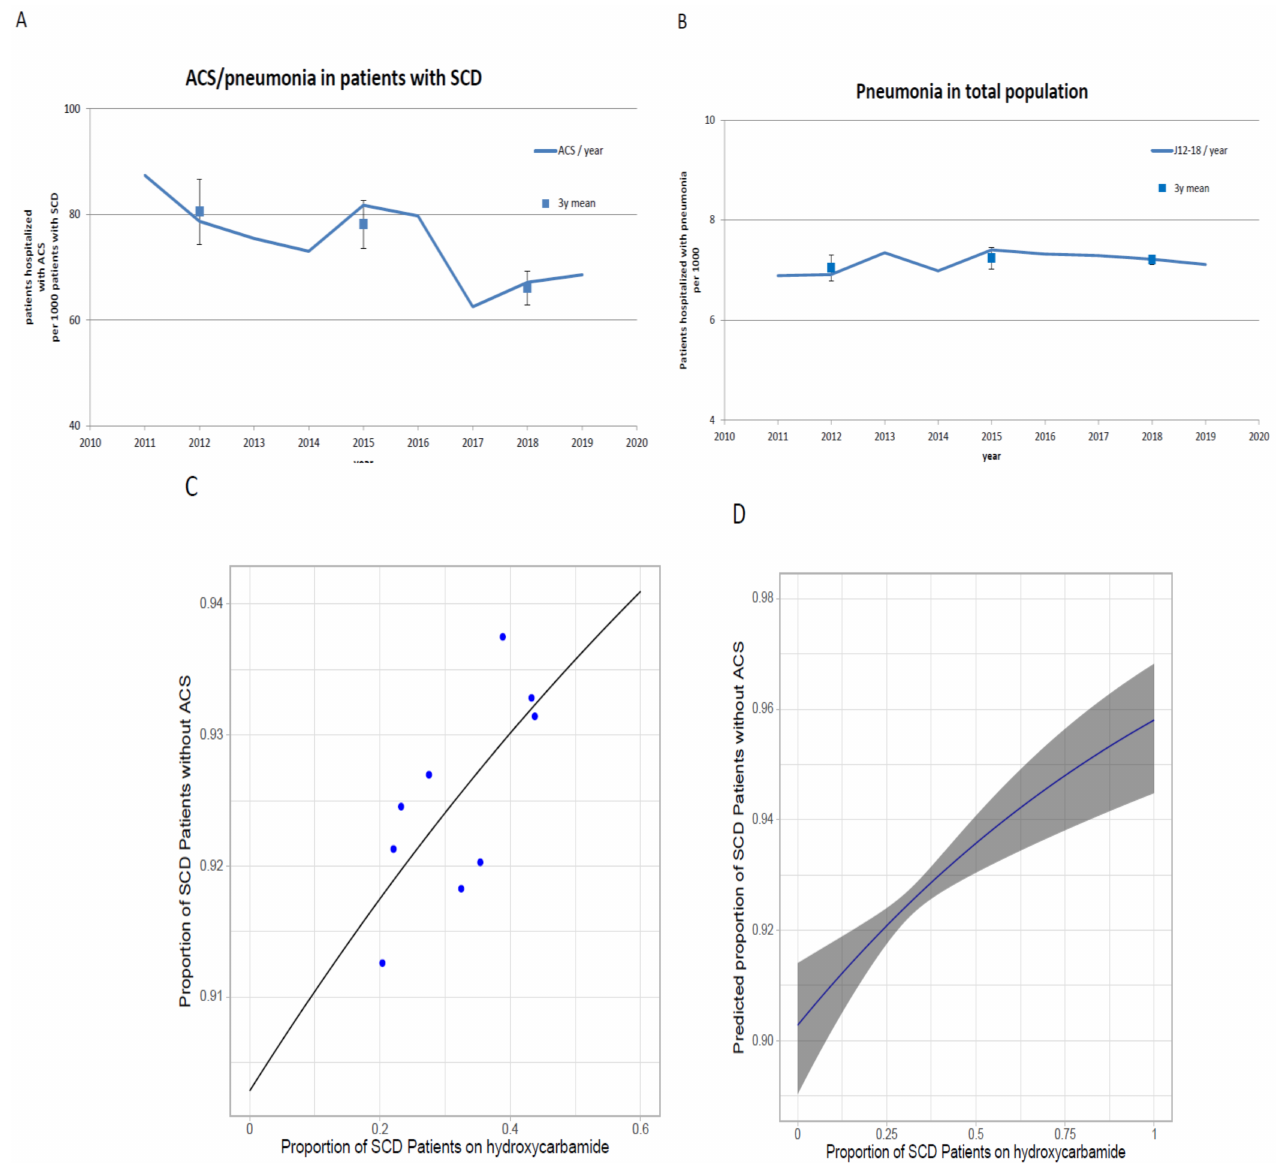
Figure 4. Acute chest syndrome/pneumonia in patients with SCD and in the general population. ( A ) Proportion of patients with SCD admitted with the diagnosis “pneumonia” (ICD10 J12–18) and ( B ) proportion of the total population admitted with the diagnosis “pneumonia” (J12–18). In order to account for the changing distribution of age and sex, patients’ numbers were normalized to the German population in 2019. Square: 3 years mean, error bars: standard deviation. ( C , D ): Visualization of a univariate logistic regression model evaluating the association between hydroxyurea treatment and ACS in patients with SCD. ( C ) Actual data (each dot represents one year) and crude regression line. ( D ) Predicted model with proportions of patients without ACS and 95% CI in dependence of the proportion of patients on hydroxyurea. Model estimates: y = (e β 0+x β 1 )/(1 + e β 0+x β 1 ) with β 0 = 2.229 (SE 0.069) and β 1 = 0.009 (SE 0.002), x = proportion of patients on